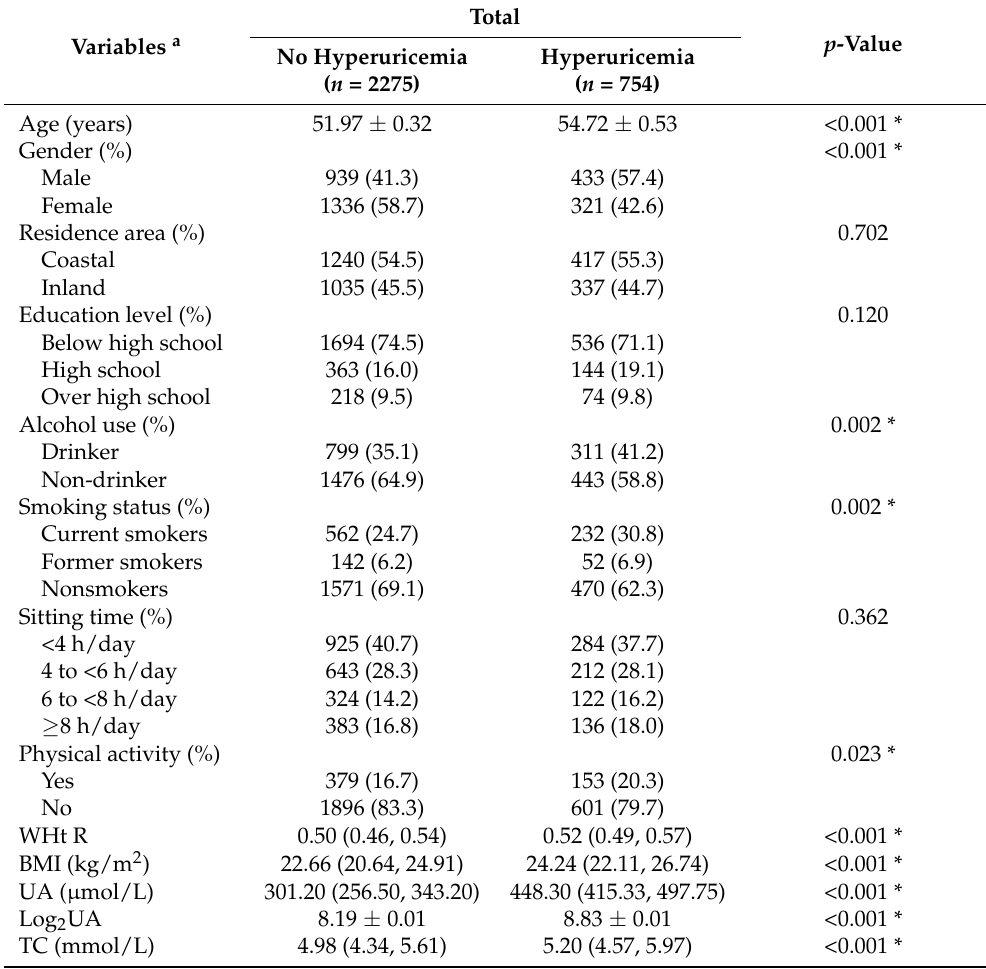
Table 1. Baseline characteristics of the study